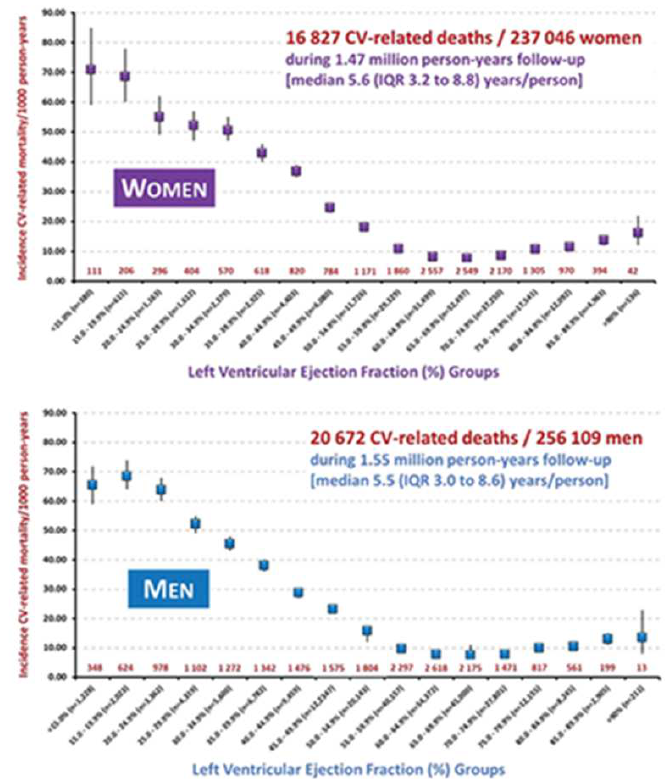
Figure 2. Sex-related differences in the incidence rate of cardiovascular (CV) mortality. Reprinted with permission from Stewart S, Playford D, Scalia GM et al. Ejection fraction and mortality: a na- tionwide register-based cohort study of 499,153 women and men. Eur. J. Heart Fail 2021;23:406–416 [16]. Copyright © The Author(s) 2020. European Journal of Heart Failure published by John Wiley & Sons Ltd on behalf of European Society of Cardiology.